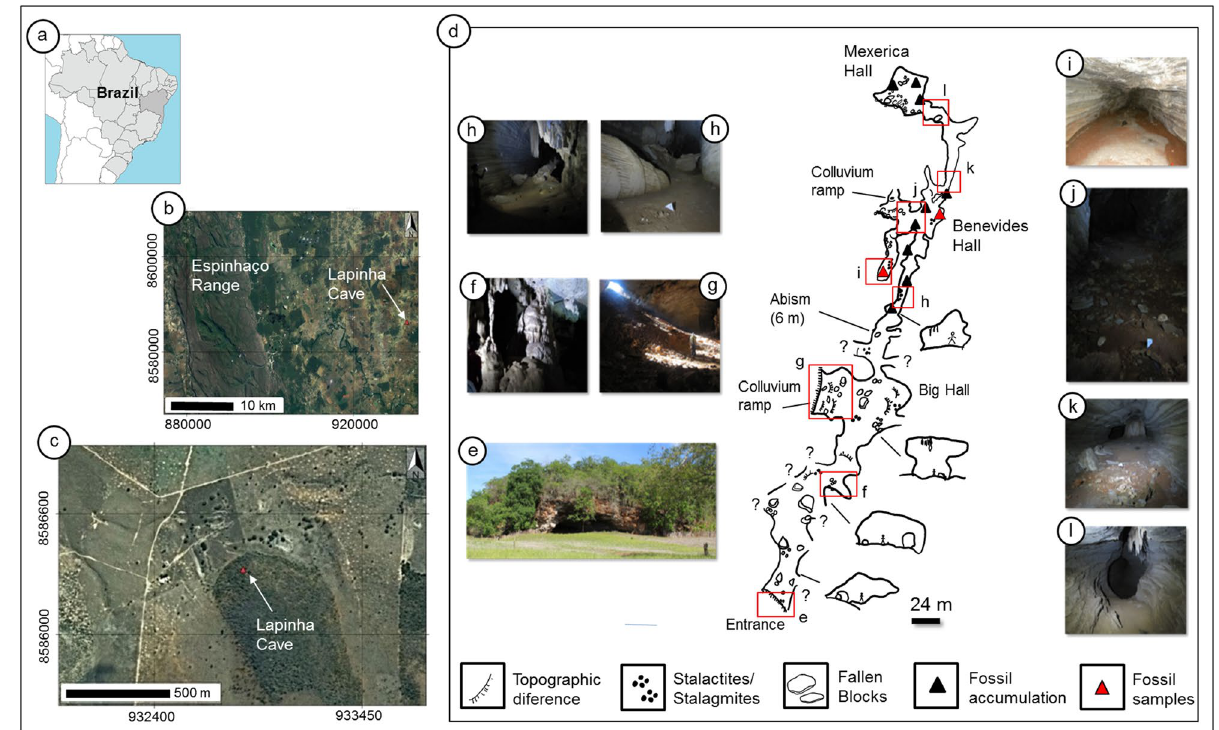
Figure 1. Detailed ( a ), ( b ), and ( c ). Location of Lapinha cave. Figure ( d ) shows a map of the cave, in which the entrance and different locations are shown with their corresponding photos ( e – l ). The red triangles show samples that were collected at the fossil-bearing